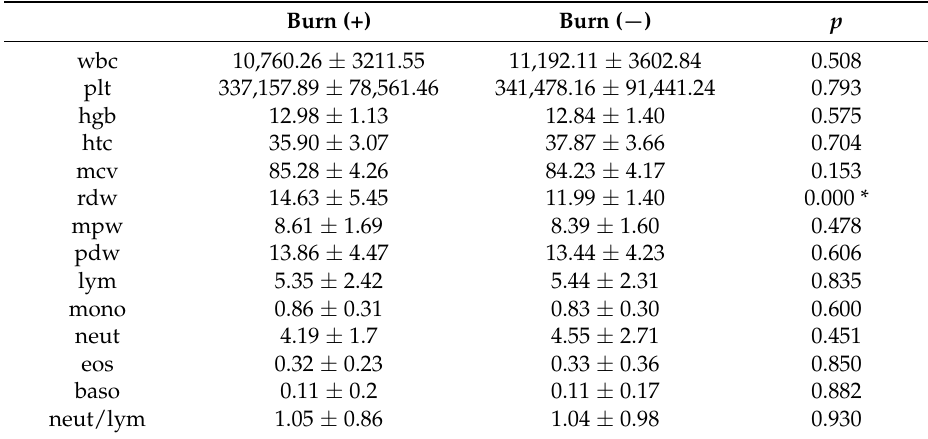
Table 3. Laboratory values of the